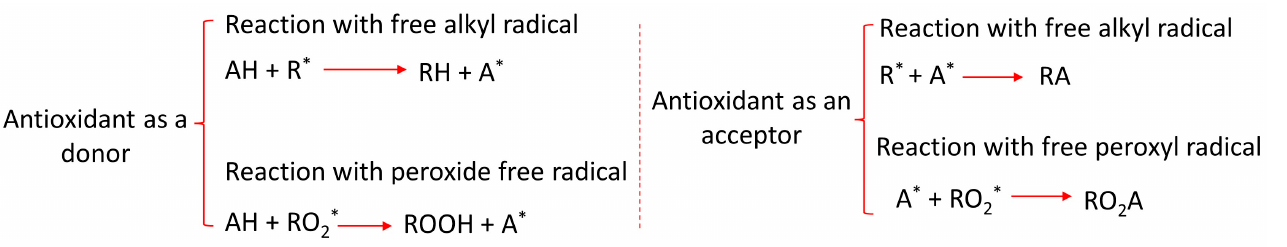
Figure 7. Reaction between antioxidant and the free radicals in the oil.